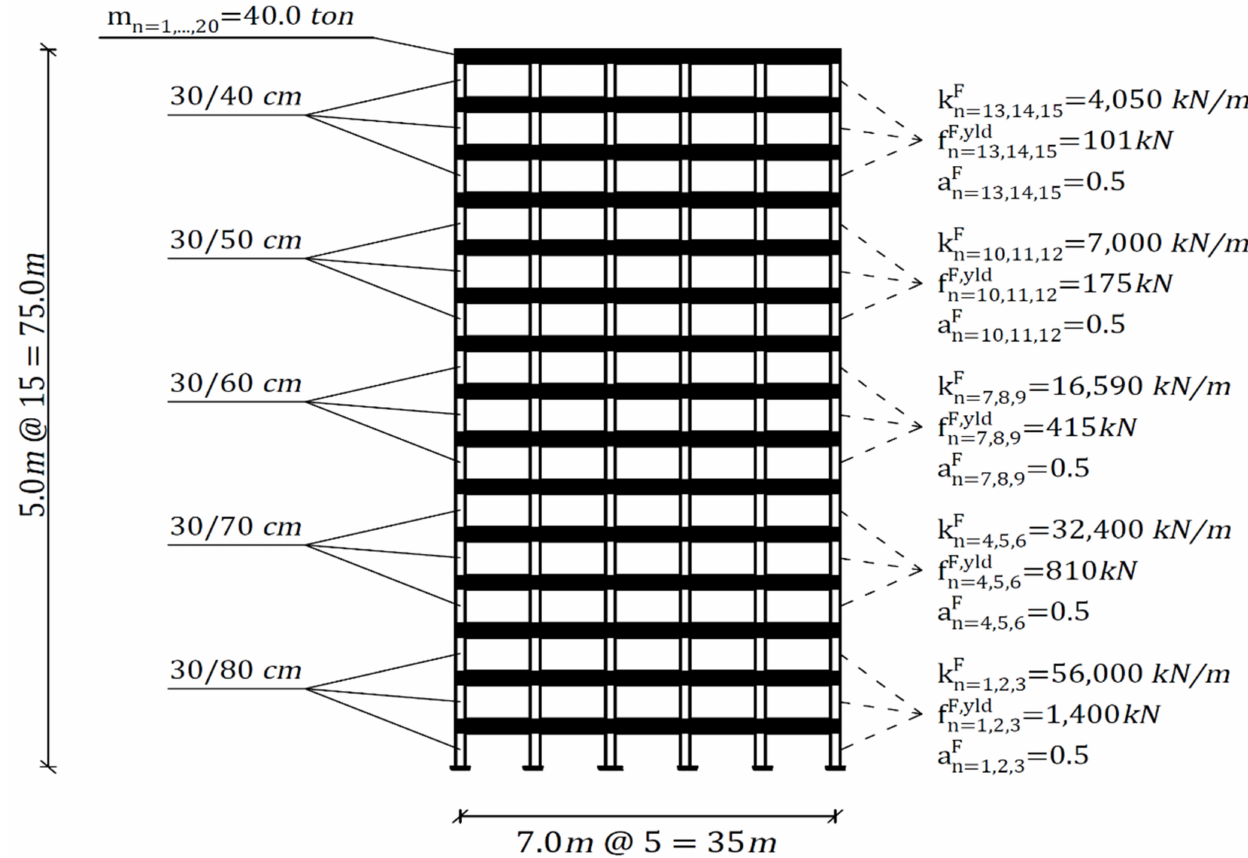
Figure 11. Fifteen-story inelastic rigid frame